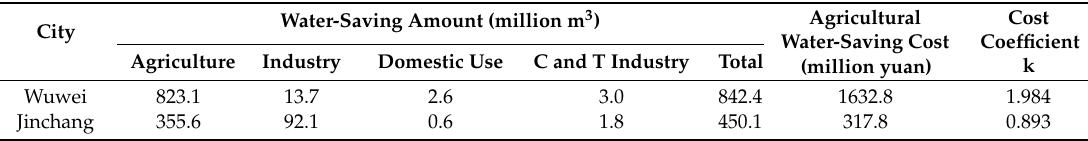
Table 8. Expected water-saving costs and amounts for Wuwei and Jinchang in 2020.